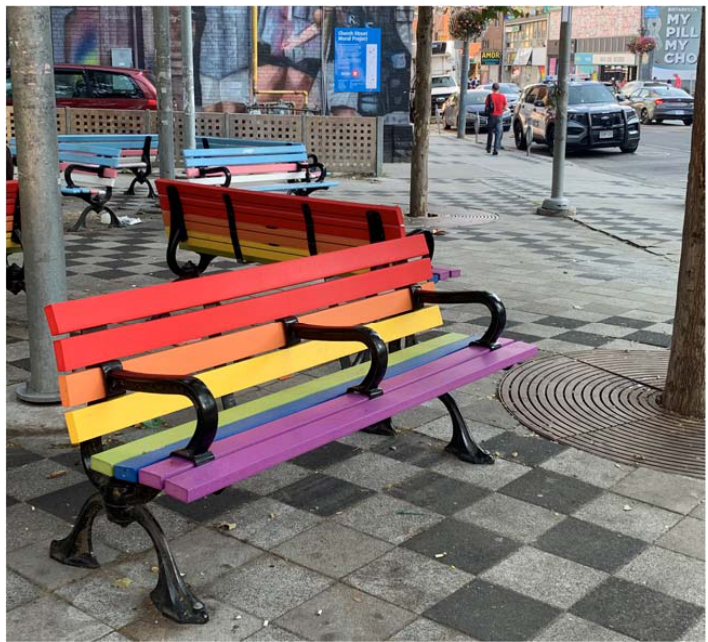
Figure 1. Pride flag painted benches situated along the west side of Barbara Hall park in Toronto’s Church-Wellesley Village neighbourhood.